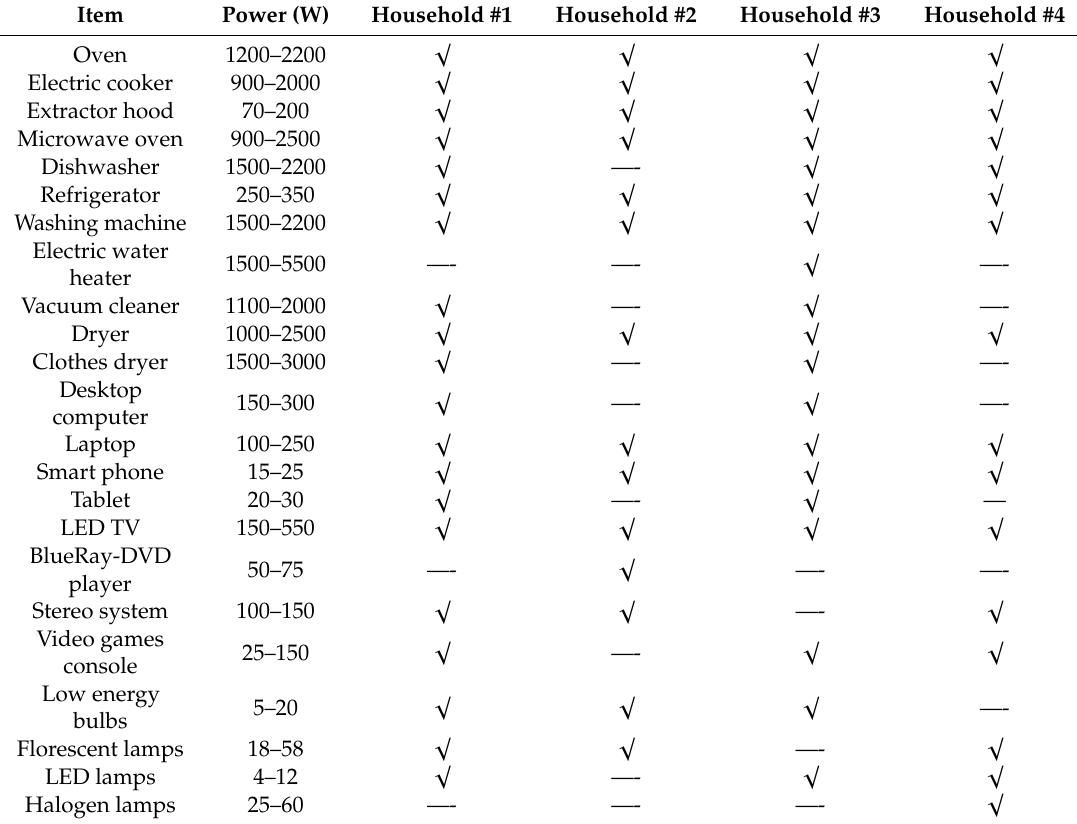
Table 3. Appliances and lighting installed in every household case